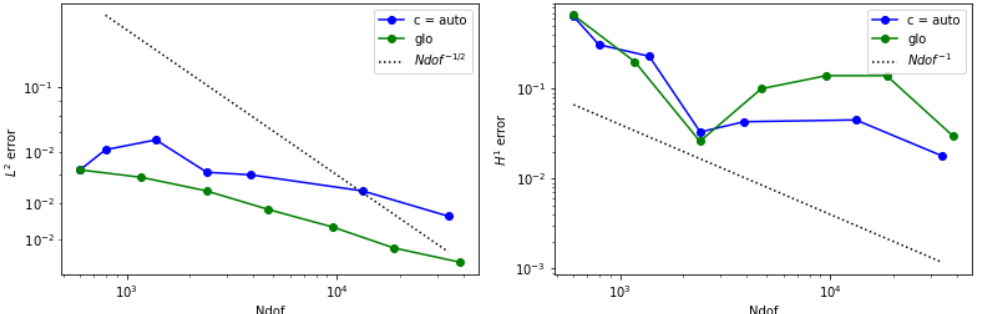
Figure 26. Error behavior for example 4 when η N is adopted. ( Left ) The estimated L 2 norm of the error is displayed. ( Right ) The estimated H 1 seminorm is